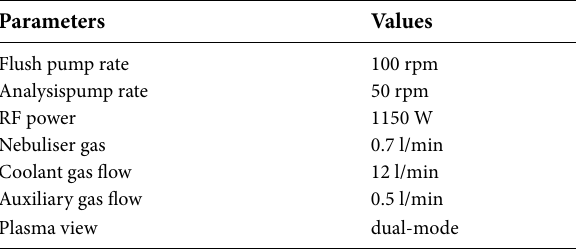
Table 1. Operational parameters for ICP-OES measurements Parameters